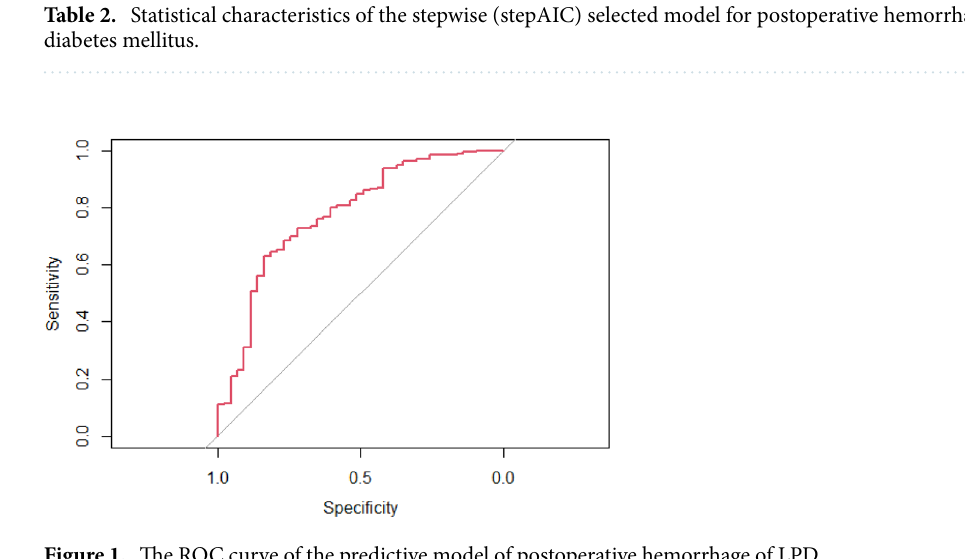
Figure 1. The ROC curve of the predictive model of postoperative hemorrhage of